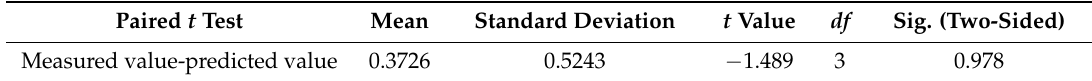
Table 4. The t -test result between reference values and prediction